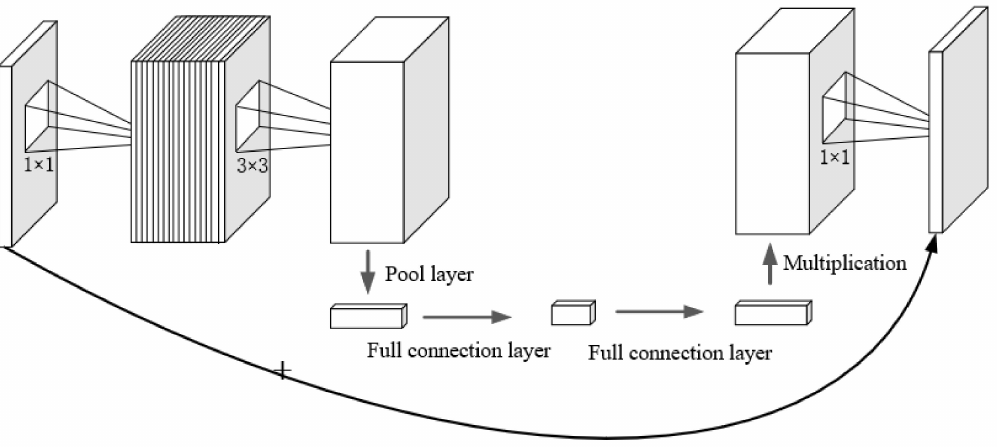
Figure 4. Bneck structure schematic diagram in